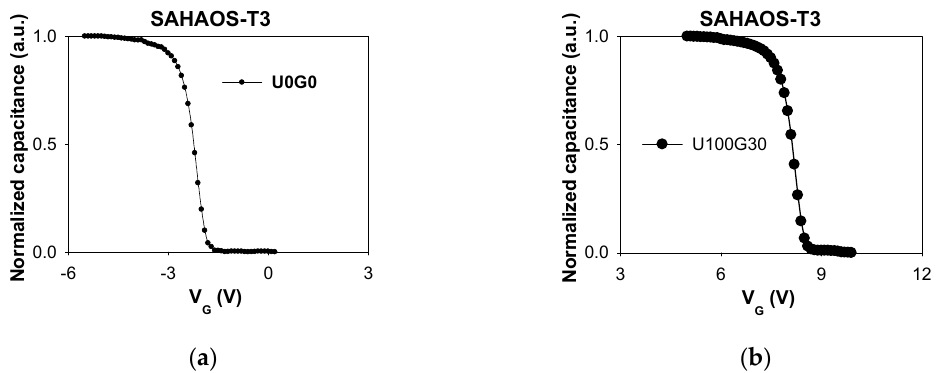
UV TD irradiation at PGV 30 V.